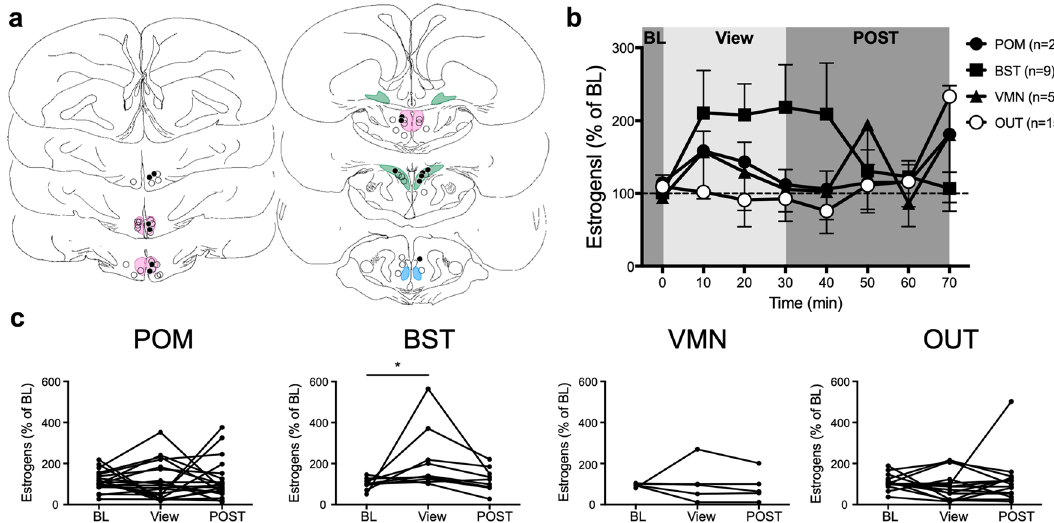
Figure 5. Visual access to a female increases estrogen concentrations in the BST. ( a ) Location of the dialysis probes. IN probes are either within or touching the colored zones representing brain regions expressing aromatase. See legend of Fig. 1 for the definition of different brain areas. Black and open circles respectively represent birds in which estrogen concentrations did or did not increase above 150% of the baseline (BL) during the visual interaction period (last sample). ( b ) Time course of the mean percentage of estrogen concentration in the dialysate (based on the mean concentration measured in the last 3 BL samples). Friedman ANOVA: POM, χ 2 χ 2 χ 2 χ 2 n=20 = 9.241, p = 0.2358; BST, n=9 = 14.69, p = 0.0402; VMN, n=5 = 13.28, p = 0.0655; OUT, n=15 = 13.15, p = 0.0686. No post hoc comparison reached statistical significance. ( c ) Individual percent changes in estrogen concentration relative to BL in the three sampling periods for individuals whose probe was in the POM, BST, VMN, or outside any nuclei expressing aromatase (OUT). Friedman ANOVA: POM: χ 2 n=20 = 1.532, p = 0.4649; BST: χ 2 n=9 = 7.0, p = 0.0249, No post hoc comparison reached statistical significance; VMN: χ 2 n=5 = 6.000, p = 0.0694; OUT: χ 2 n=15 = 0.3415, p = 0.8430. View: Period when the male has visual access to the female, POST: Period after the behavioral test. The baseline amounts of estrogens per sample in this experiment ranged between 0.026 and 1.463 pg per sample (10 µl; Mean ± S.E.M. = 0.159 ± 0.027, n = 49). Panel A is composed of home made drawings onto which probe positions were reported using Graphic for Mac (https:// graph ic. com/ mac/), other panels were created with Graph Pad Prism 8 (https:// www. graph pad. com/ scien tific- softw are/ prism/). All panels were assembled in